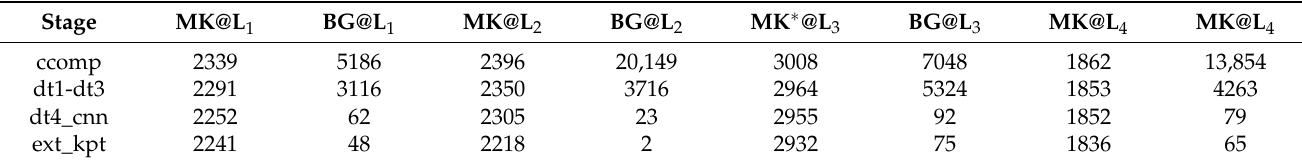
Table 2. Number of vision system outputs at different processing stages. The terms “MK” and “BG” denote marker and background categories, respectively.